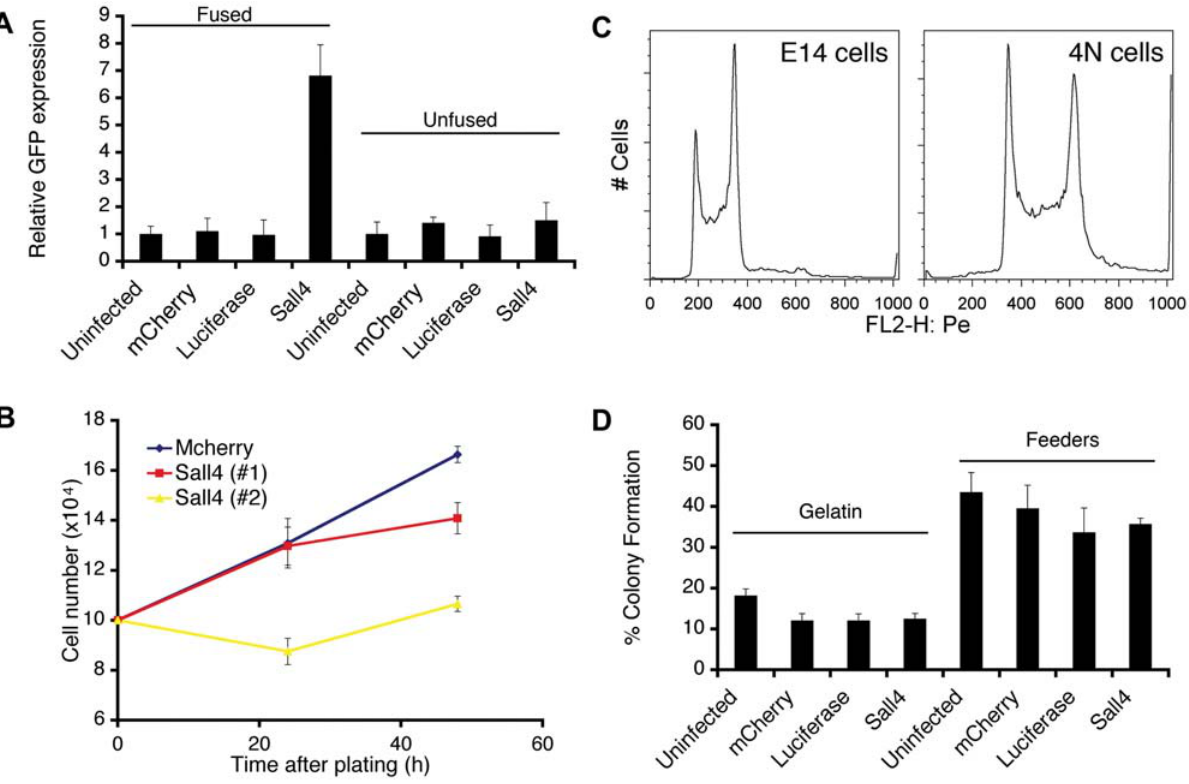
Figure 4. Sall4 is a bonafide positive regulator of reprogramming. A) Overexpression of Sall4 in Oct4-gfp MEFs did not induce GFP expression. Sall4, mCherry and luciferase were overexpressed in Oct4-gfp MEFs via lentivirus infection. Half of the infected MEFs was fused to ESCs as described, while the other half was not. Only MEFs overexpressing Sall4 and fused to ESCs showed an increased number of GFP positive cells when compared to the negative controls, indicating that overexpression of Sall4 alone did not induce GFP expression. The numbers of GFP positive cells in the infected cells relative to that of the uninfected cells were shown. B) Overexpression of Sall4 did not increase cell doubling time in MEFs. mCherry and two different constructs of Sall4 were overexpressed in MEFs, which were plated onto 6 well plates and assayed for cell number every 24 h. Note that another clone of Sall4 of identical sequence was used as a duplicate. C, D) Infection of Sall4-expressing lentiviruses did not increase the colony formation efficiency in ESCs. Both ESCs and previously reprogrammed MEFs that were tetraploid were infected with lentiviruses expressing Sall4, mCherry or luciferase. D) The infected cells were plated either on gelatin or on feeder cells. The number of colonies formed was assayed after 7 days.